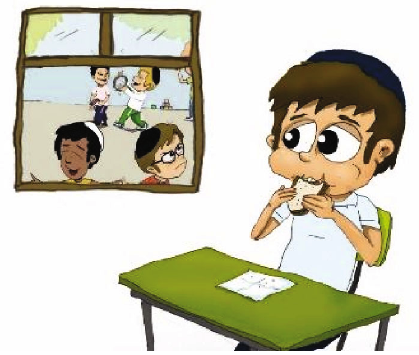
Figure 1: “ Daniel does not fi nish eating his sandwich during the meal break. ”